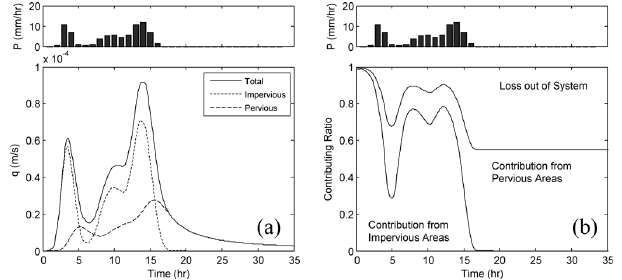
1 Figure 10 Flow discharge per unit area in CDS-51 with a triangular hyetograph and maximum 2 Fig. 10. Flow discharge per unit area in CDS-51 with a triangular intensity of 10 mm/hr when (a) r c = 0; (b) r c = 0.5 3 hyetograph and maximum intensity of 10mmh − 1 when (a) r c = 0, 4 (b) r c = 0 . 5.